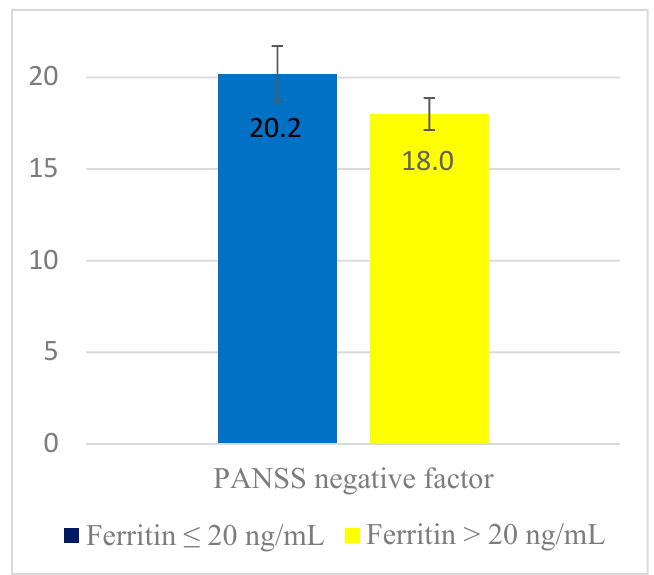
Figure 1. Adjusted mean (95% confidence interval) of Positive and Negative Syndrome Scale (PANSS) negative factor score according to iron deficiency. Adjustment for sex, inpatient status, duration of untreated psychosis, duration of treatment, and scores on the Social Occupational Functioning Assessment Scale, Calgary Depression Scale for Schizophrenia, and PANSS positive and cognitive factors. F = 5.471, p -value = 0.021.